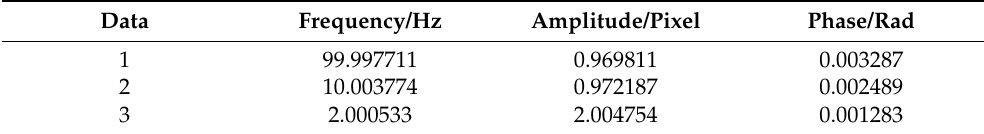
Table 6. Jitter modeling results of three different frequencies by sequential disparity